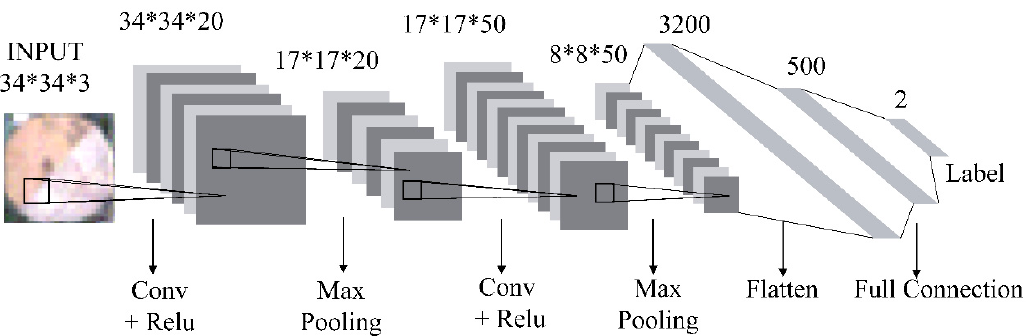
Figure 5. Architecture of convolutional neural networks (CNNs) for center pivot irrigation systems identification following the LeNet structure.